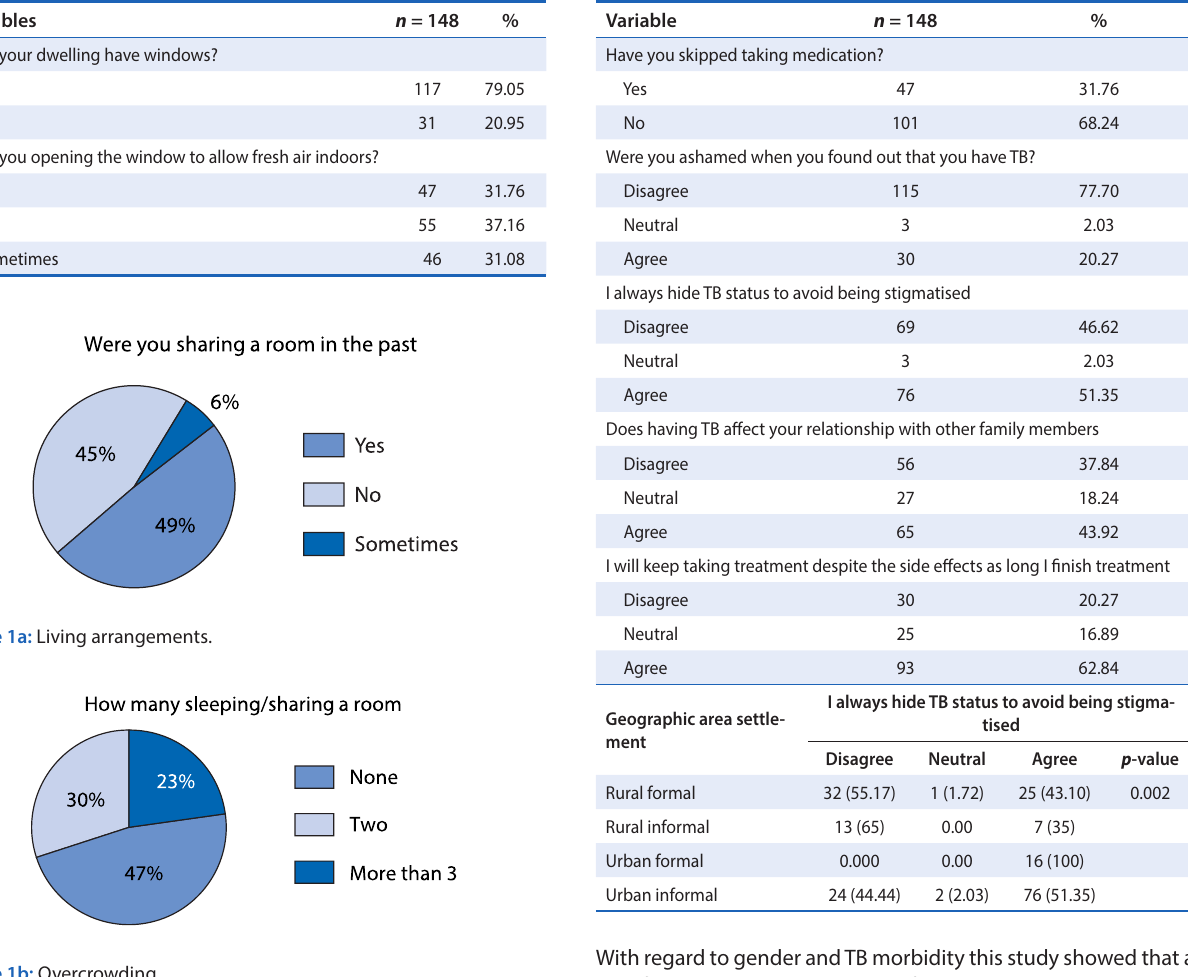
Figure 1b: Overcrowding.